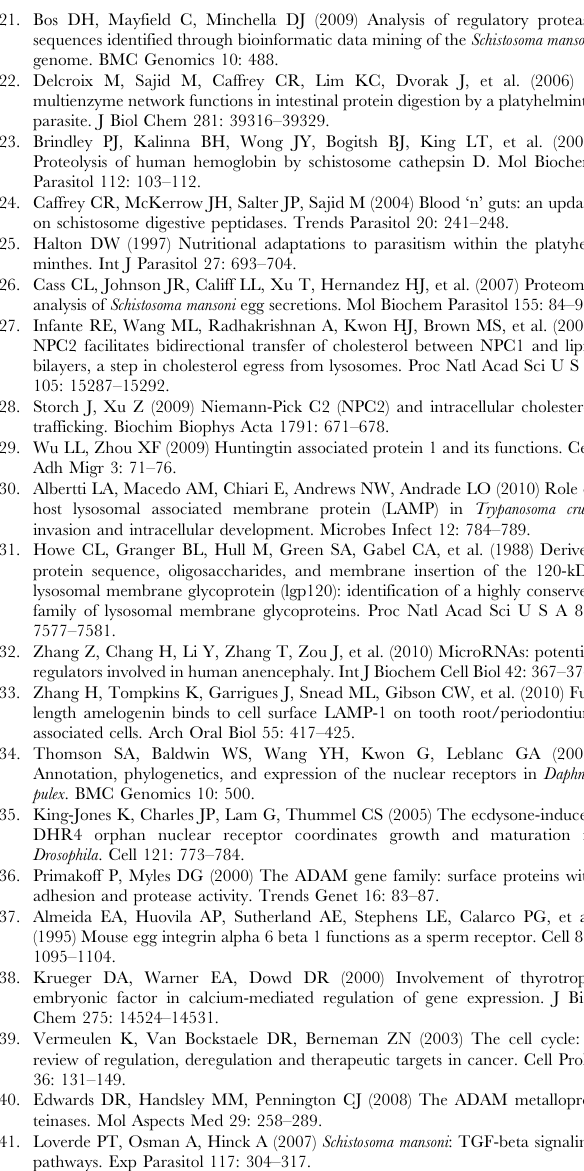
Table S11 Complete list of 91 differentially upregulated genes (2 fold or higher than the male control) in the S. mansoni male hind